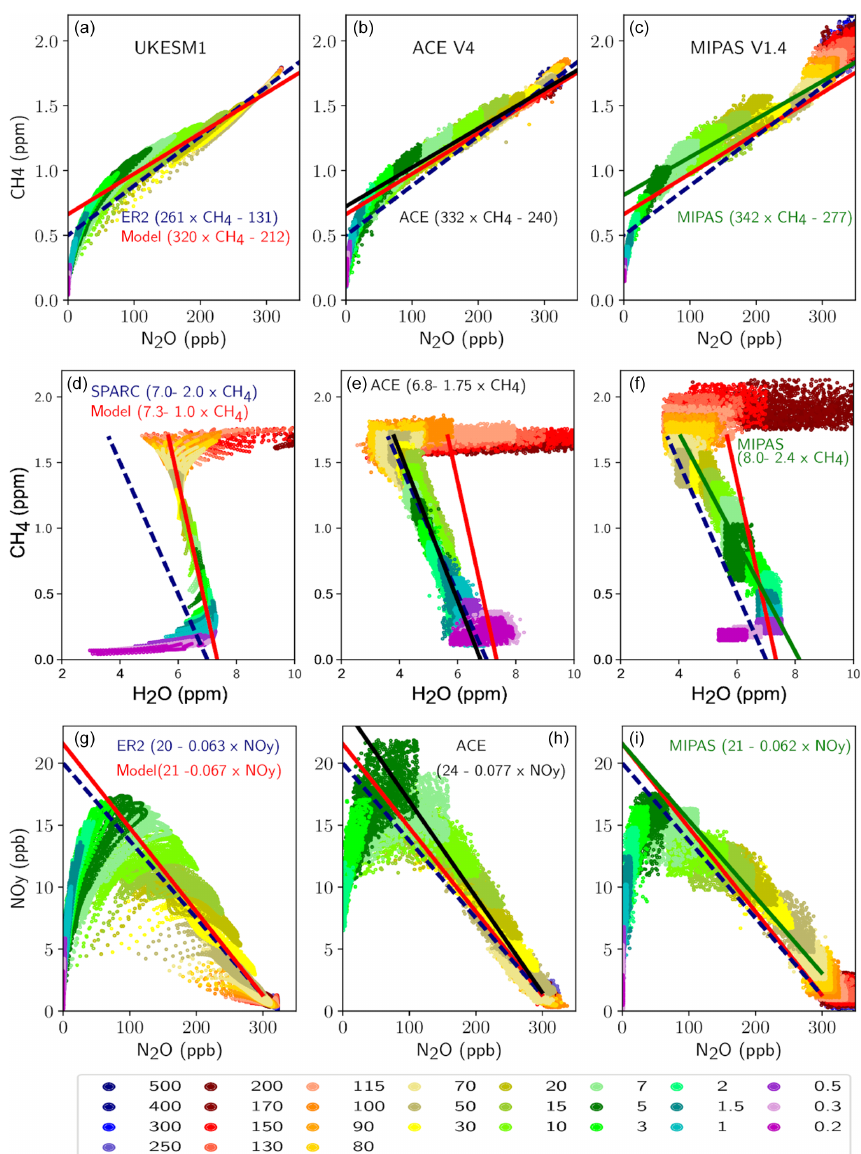
Figure 27. Correlations between selected long-lived chemical species (monthly mean zonal-mean values for 60 ◦ S–60 ◦ N) from FR UKESM1 (a, d, g) , ACE V4 data (b, e, h) and MIPAS data (c, f, i) . The coloured legend shows the corresponding pressure level (hPa) of the data points. The linear regression fits to the model, ACE and MIPAS data are shown in the respective panels along with the equa- tions of the lines. The MIPAS data are the same as those used in Figs. 6.12, 6.13 and 6.14 in the CCMVal-2 report (SPARC, 2010). ACE NO y values are calculated as NO y = NO + NO 2 + HNO 3 + 2N 2 O 5 + ClONO 2 . (a–c) CH 4 vs. N 2 O. The linear fit is calculated for N 2 O values ranging from 100 to 300ppb. The dashed line shows the estimated fit from ER-2 data (N 2 O (ppb) = 261 . 8 × CH 4 (ppm) − 131; see Kawa et al., 1993). (d–f) CH 4 vs. H 2 O. The linear fit is calculated for CH 4 values ranging from 0.5 to 1.5ppm. The dashed line represents H 2 O + 2CH 4 = 7ppm. (g–i) NO y vs. N 2 O. The linear fit is calculated for N 2 O values ranging from 100 to 300ppb, and the dashed line shows the equation NO y (ppb) = 20 . 0 − 0 . 0625 × N 2 O (ppb) based on mid-latitude balloon profiles and ER-2 data (see Kondo et al.,